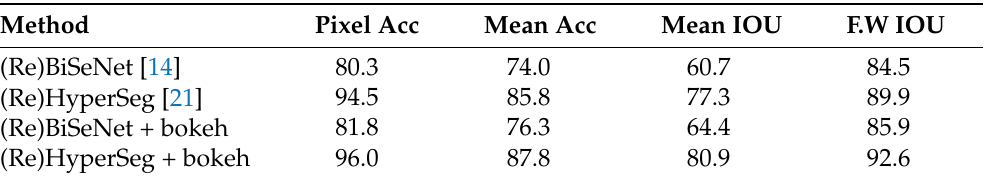
Table 6. Accuracy result on the CamVid val dataset. After adding the bokeh module, the result is improved by 3.7 points.